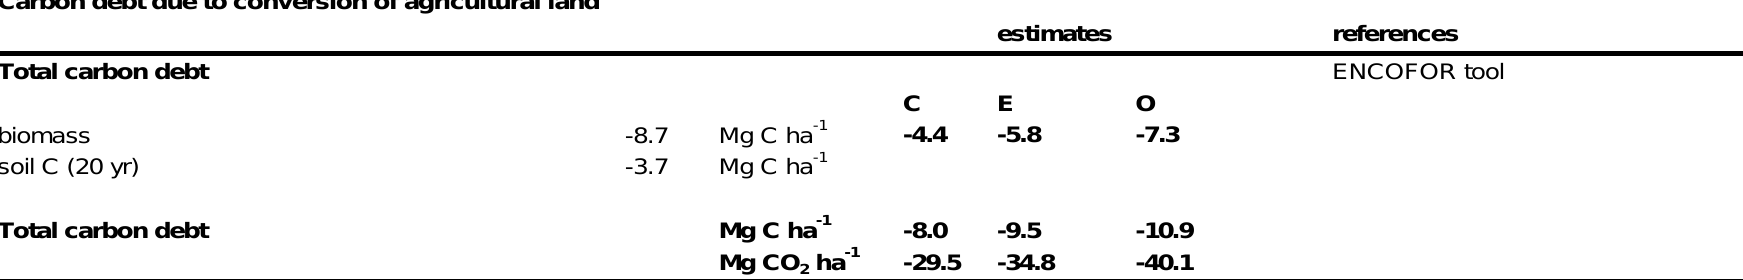
Table A4.2. continued Carbon debt calculation of Michoacan, Mexico case